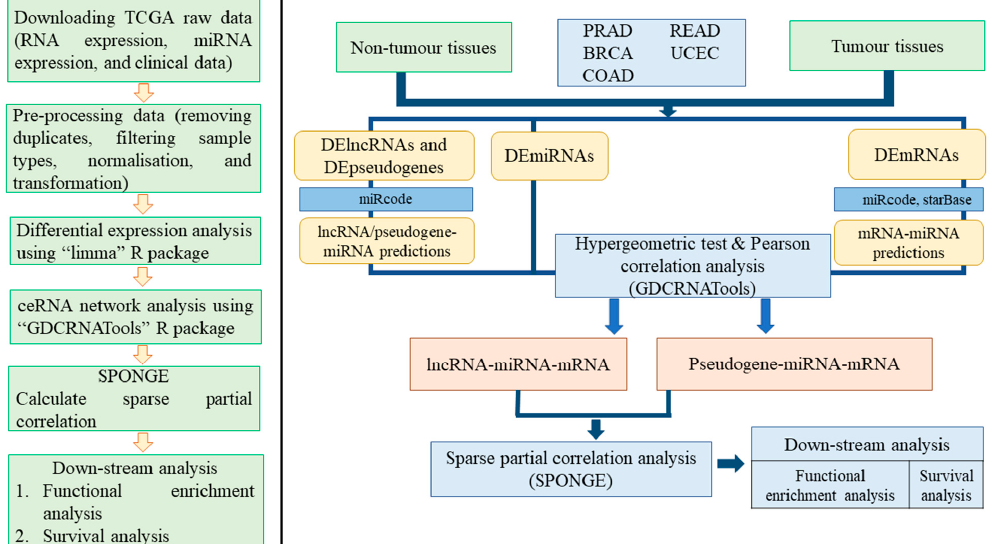
Figure 1. Methodological workflow of the study. RNA-seq and miRNA-seq data extracted from The Cancer Genome Atlas (TCGA) were pre-processed, normalised, and transformed into a standard scale. Differential expression analysis was conducted to identify differentially expressed (DE) long non-coding RNAs (lncRNAs), pseudogenes, messenger RNAs (mRNAs), and microRNAs (miRNAs). The competing endogenous RNA (ceRNA) network analysis followed three steps: (i) identifying lncRNA/pseudogene–mRNA pairs sharing the significant number of miRNAs, (ii) calculating the Pearson correlation between lncRNA/pseudogene and mRNAs, and (iii) calculating multiple sensitivity correlation considering a set of miRNAs targeted by a given lncRNA/pseudogene–mRNA pair. The first two steps were conducted using the GDCRNATools R/Bioconductor package [19]. For step iii, sparse partial correlation analysis was executed using the SPONGE (sparse partial correlation on gene expression) R/Bioconductor package [20]. The three-step analysis filtered out statistically significant ceRNAs for individual HD cancers. Then, only shared ceRNA components across all five HD cancers were involved in the downstream